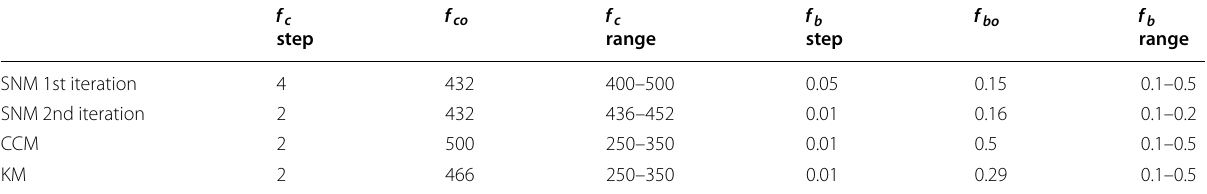
Table 4 Searching parameters